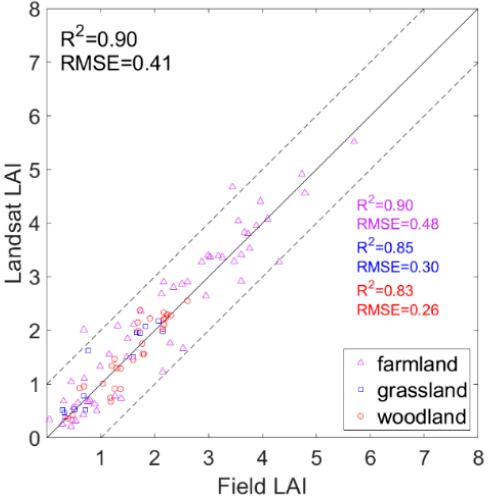
Figure 3. Scatterplot of Landsat leaf area index (LAI) estimated by SA-BP and Field LAI. LAI estimated with SA-BP was then used as the 30 m LAI observation data in the assimilation scheme. Different SA-BP models were selected based on the land cover map (Figure 1) at each site to obtain a 30 m LAI estimation.